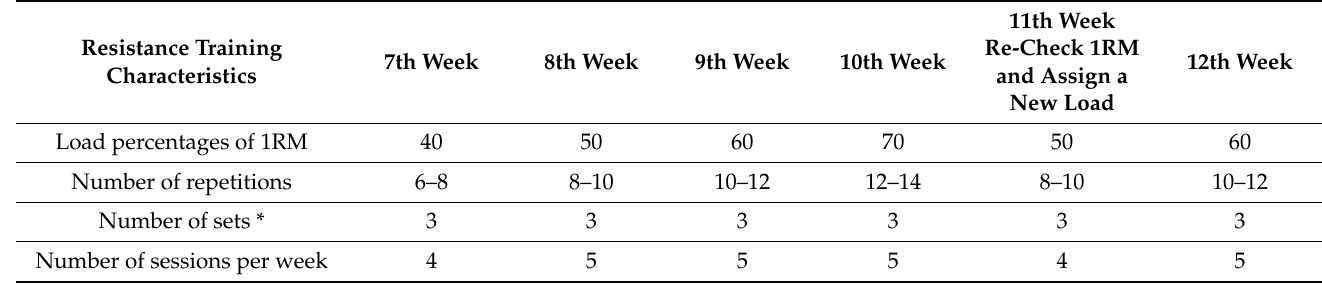
Table 1. Training details of the high sitting quadriceps and hamstrings resistance exercise.